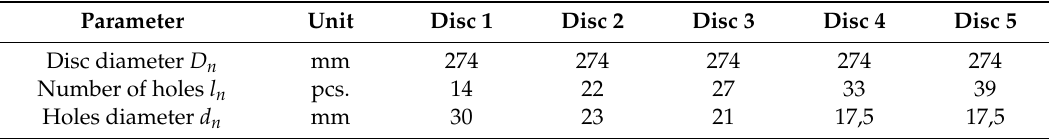
Table 2. Structural parameters of the five-disc grinder.